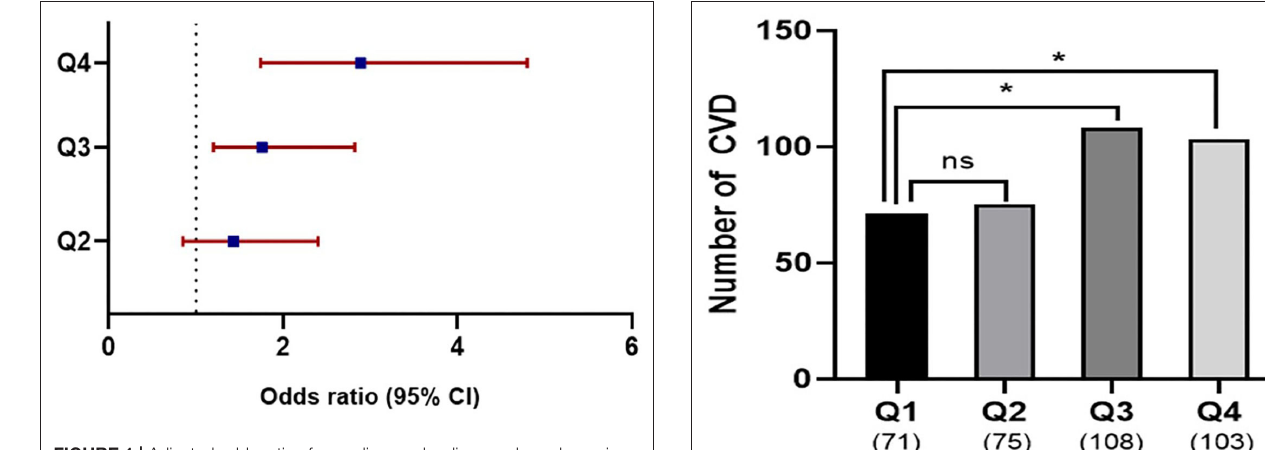
FIGURE 1 | Adjusted odds ratios for cardiovascular diseases based on uric acid variability. Odds ratios in each quartile of uric acid variability increased as the quartiles advanced: Q3 (HR = 1.76, 95% CI, 1.20–2.82, P = 0.019), Q4 (HR = 2.89, 95% CI, 1.74–4.80, P < 0.001). HR, Hazard ratio; CI, Confidence interval; Q, quartile. FIGURE 2 | Cardiovascular outcomes according to uric acid variability.